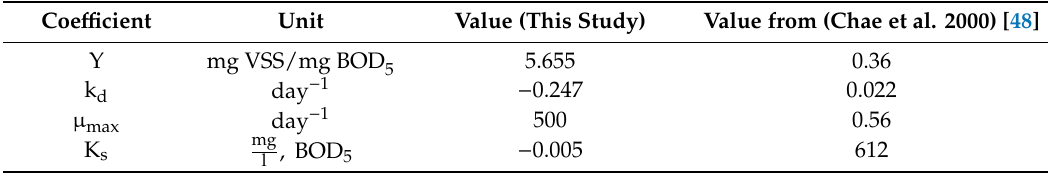
Table 8. Activated sludge system coe ffi cient of kinetic